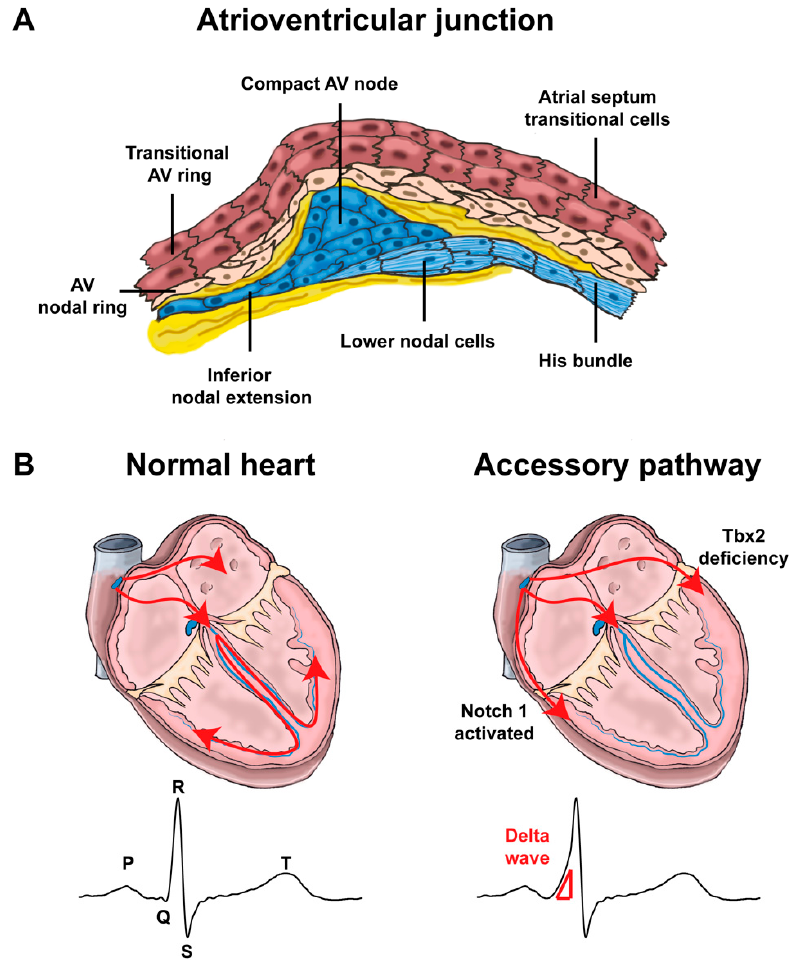
Figure 4. Atrioventricular junction and impulse propagation ( A ). Schematic representation of the different components of the atrioventricular junction (Inspired by [53,70]). Note that lower nodal cells share a common origin with the His bundle cells. (AV: atrioventricular) ( B ). In normal hearts, the electric impulses initiated by pacemaker cells in the sinoatrial node propagate through the atrial myocardium and trigger its contraction. At the atrioventricular node, the impulses are delayed for a period to facilitate alternating contraction of the atrial and ventricular myocardium. After the atrioventricular delay, the electrical impulses rapidly travel to the ventricular myocardium via the His-Purkinje system and stimulate the ventricular myocardium. In Notch1-activated and Tbx2-deficient hearts, accessory pathways are formed as a result of malformation of the atrioventricular canal myocardium, commonly right-sided in Notch1-activated mice and left-sided in Tbx2-deficient mice. Because of faster conduction through the accessory pathways than through the atrioventricular node, the ventricular myocardium is prematurely stimulated (preexcitation). The ECG shows a short PR interval, a slurred upstroke (“delta wave”) of the QRS complex and a widened QRS